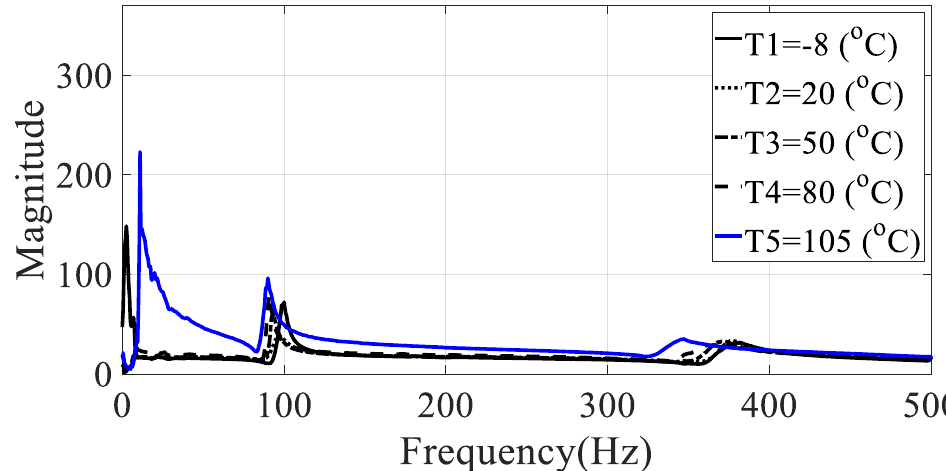
Figure 7. Representative frequency response function of specimen III ( 𝜙 = 45 degrees ) .